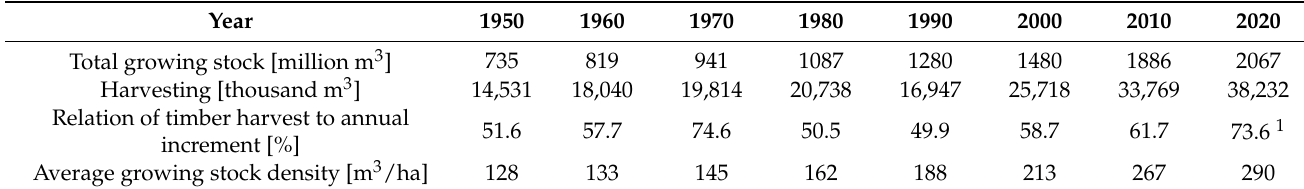
Table 6. Characteristics of wood resources of SF and their use